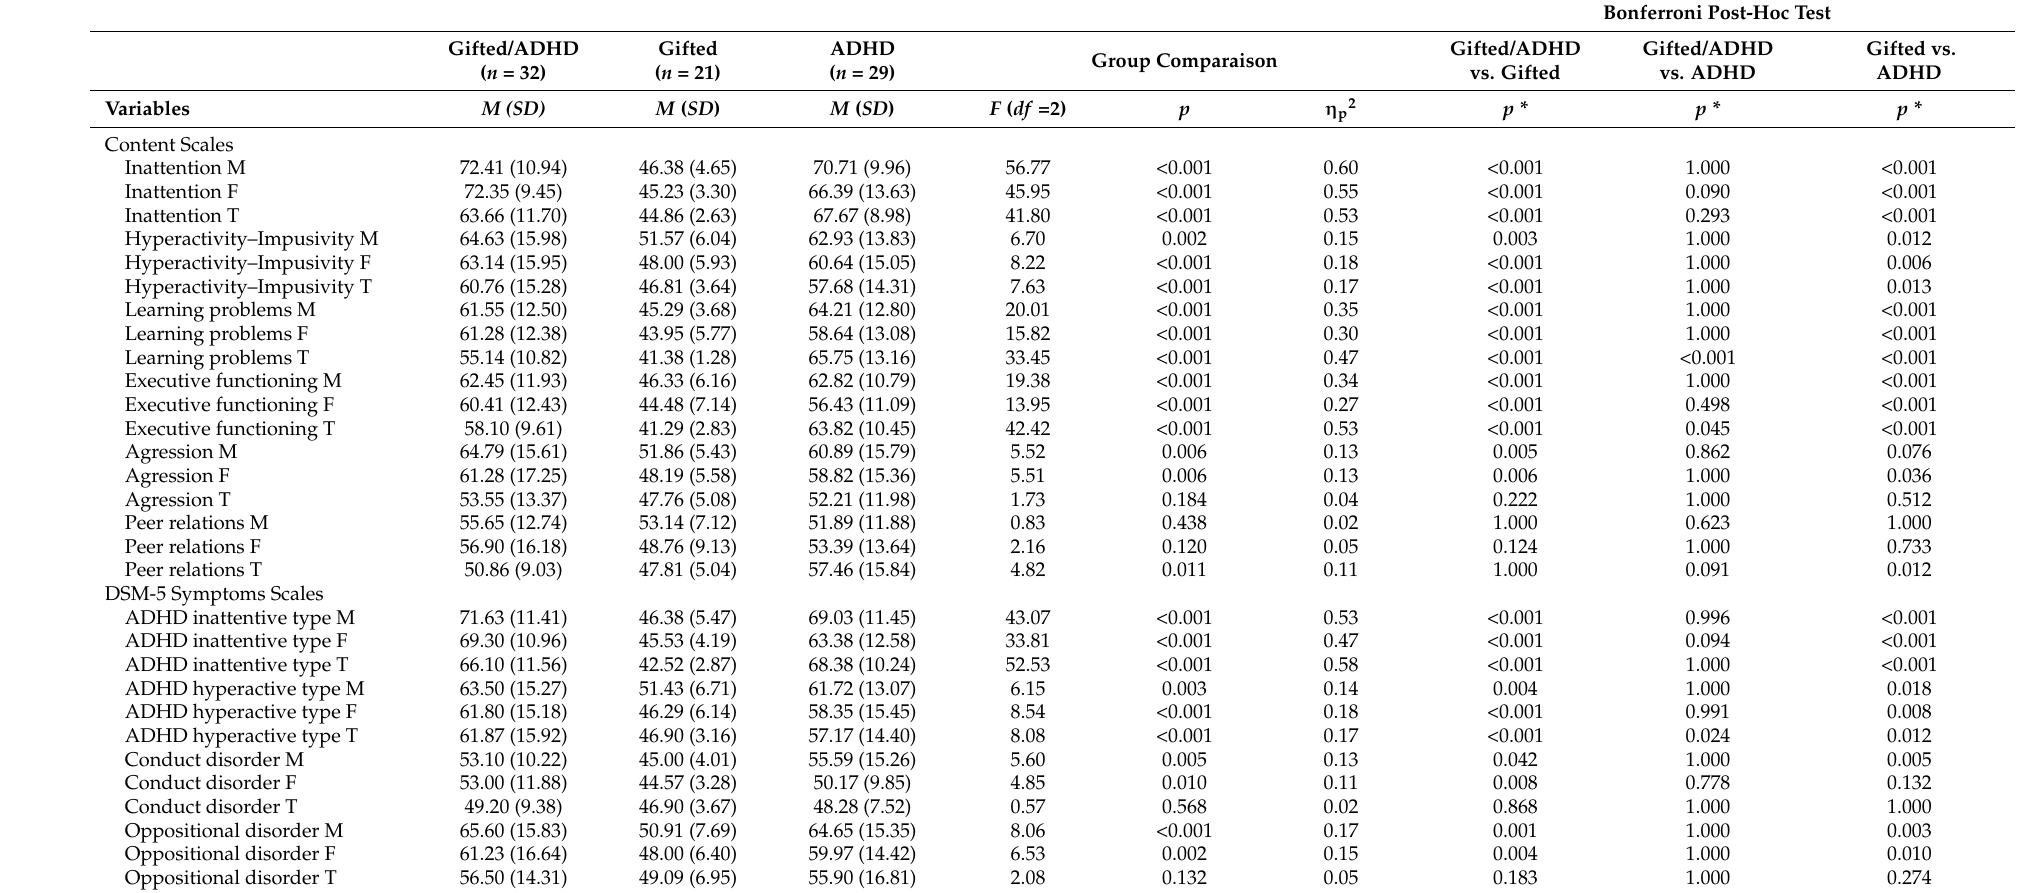
Table 2. Statistical comparison between the average scores of the different groups to the Conners